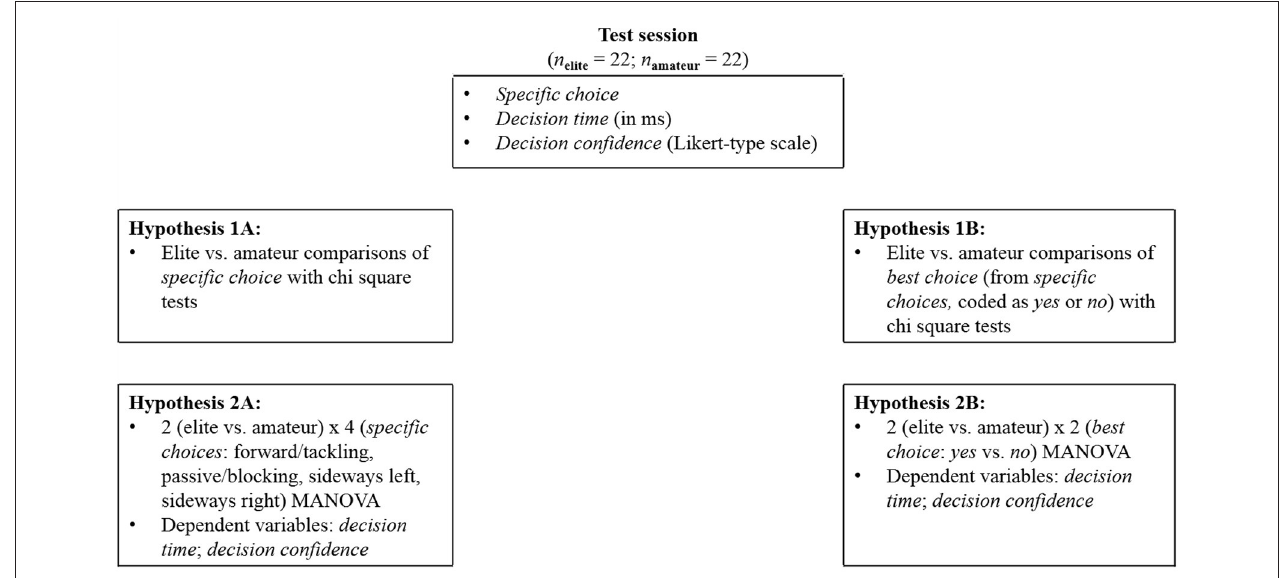
FIGURE 1 | Illustration of the study design including the respective hypotheses.